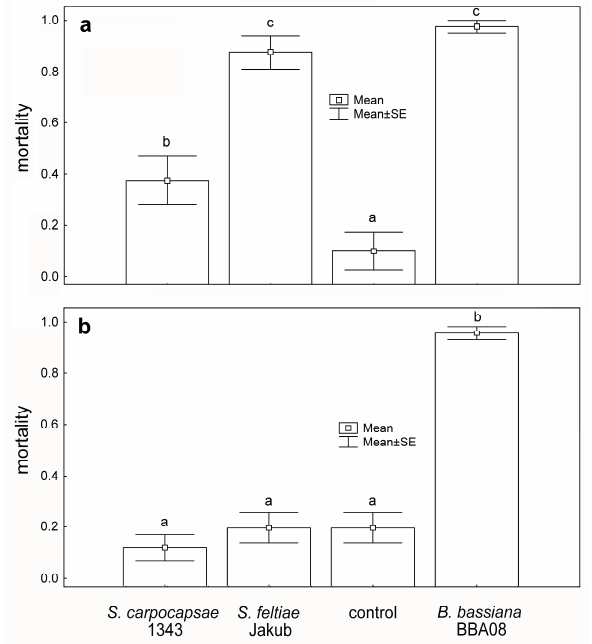
Figure 4. Mortality of pupating CPB in the soil ( a ) and adults on the potato leaves ( b ) after the application of entomopathogenic nematodes and fungus. Different letters above bars indicate statistically significant differences.